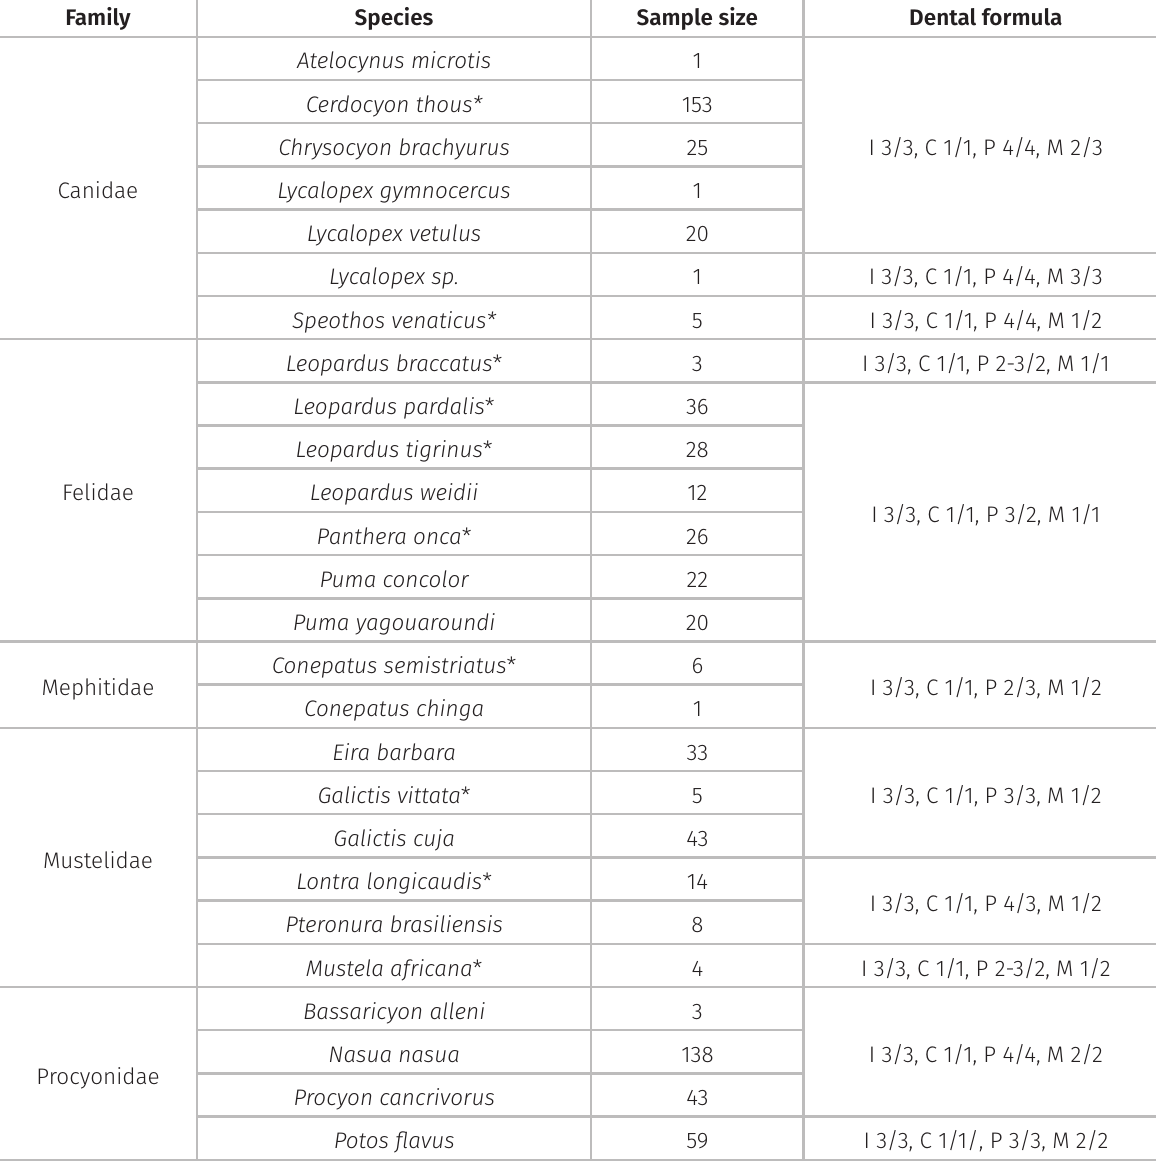
Table I. List of Carnivora taxa examined, with sample size and dental formula. Taxa marked with an asterisk (*) denote intraspecific variation in dental